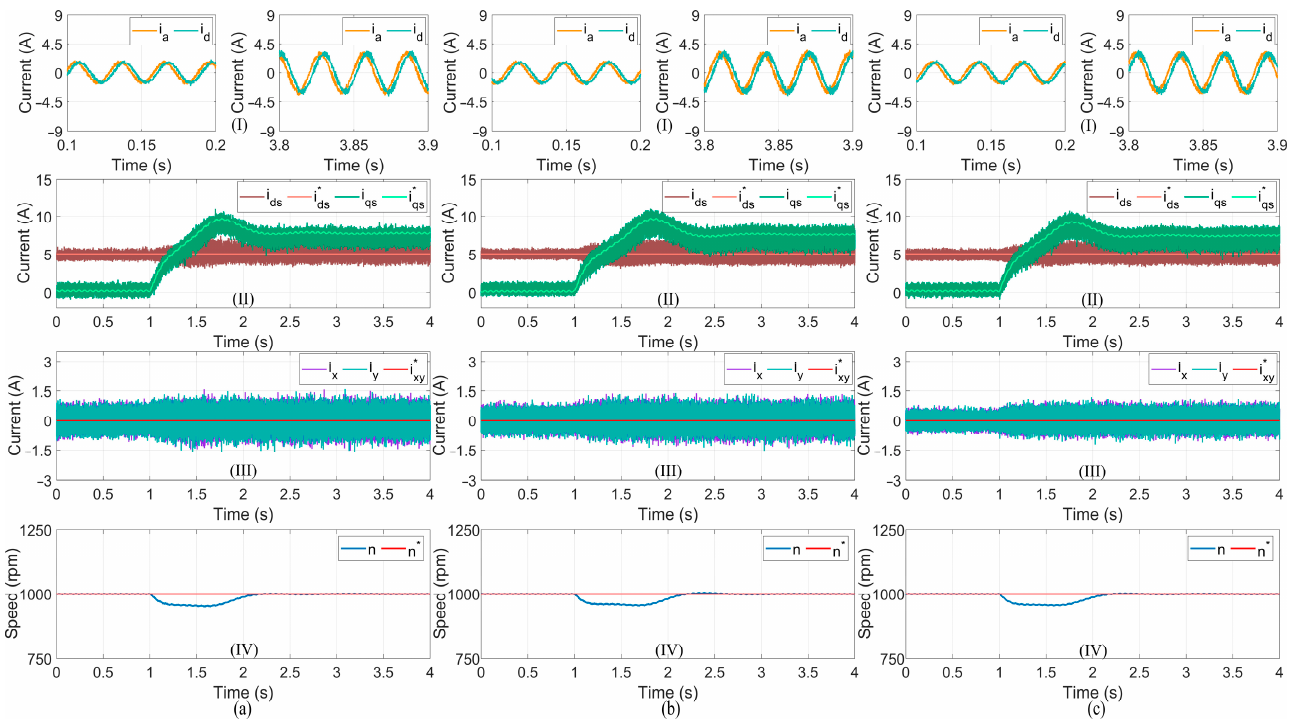
Figure 10. Test 3: MPC49 (( a ) plots), MPC13 (( b ) plots), and the proposed HMPCC (( c ) plots)). From top to bottom: (I) a and d phase currents; (II) d and q currents; (III) x and y currents; (IV) motor speed.